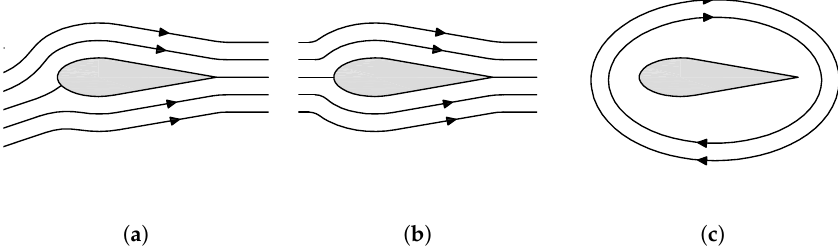
Figure 5. Schematic representation of the streamlines of an inviscid flow around an aerofoil, with ( a ) the attached flow for a small angle of attack, ( b ) a symmetric flow pattern, and ( c ) the induced circulatory flow.